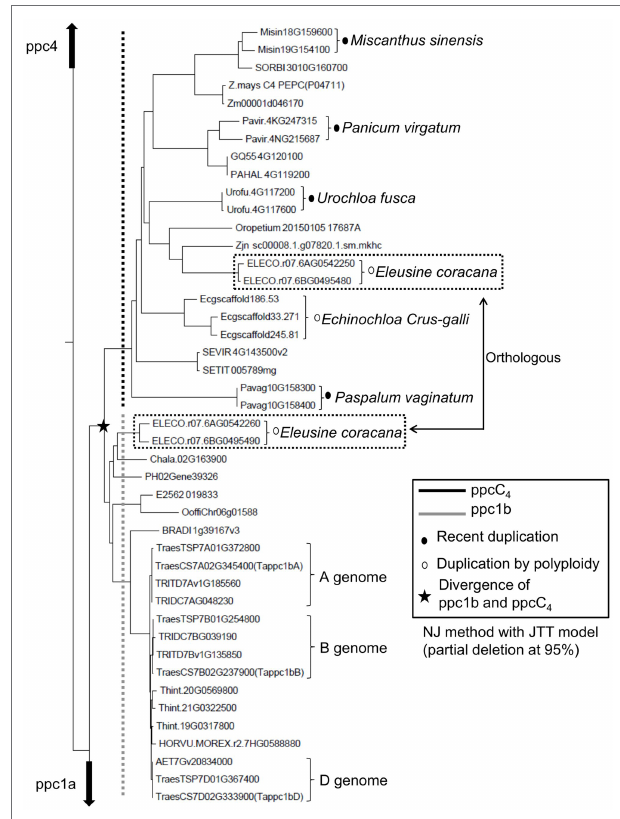
FIGURE 4 | A partial NJ tree represents the orthologous relationship between ppc1b and ppcC 4 .